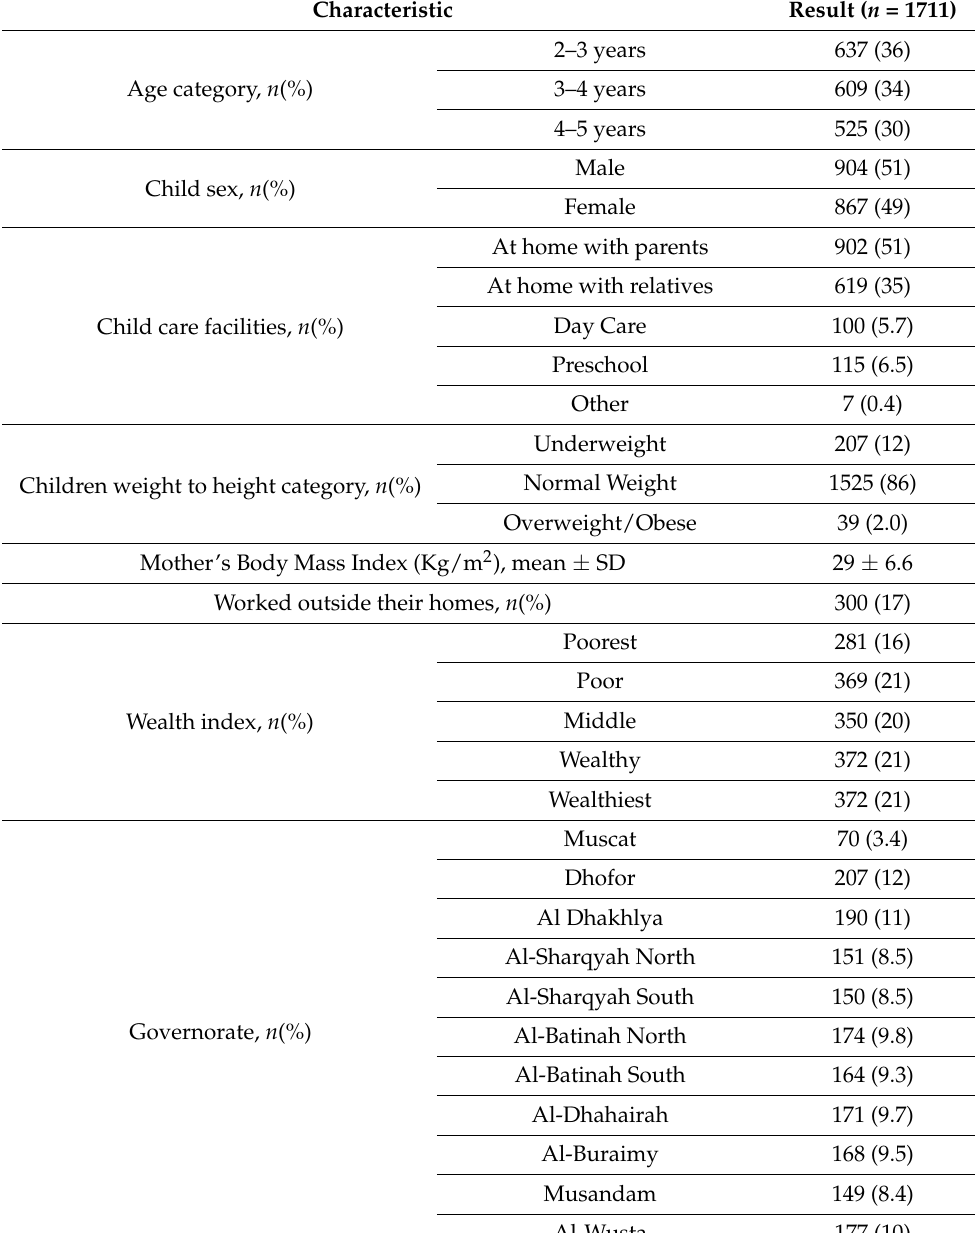
Table 1. Children and mothers’ socio demographic